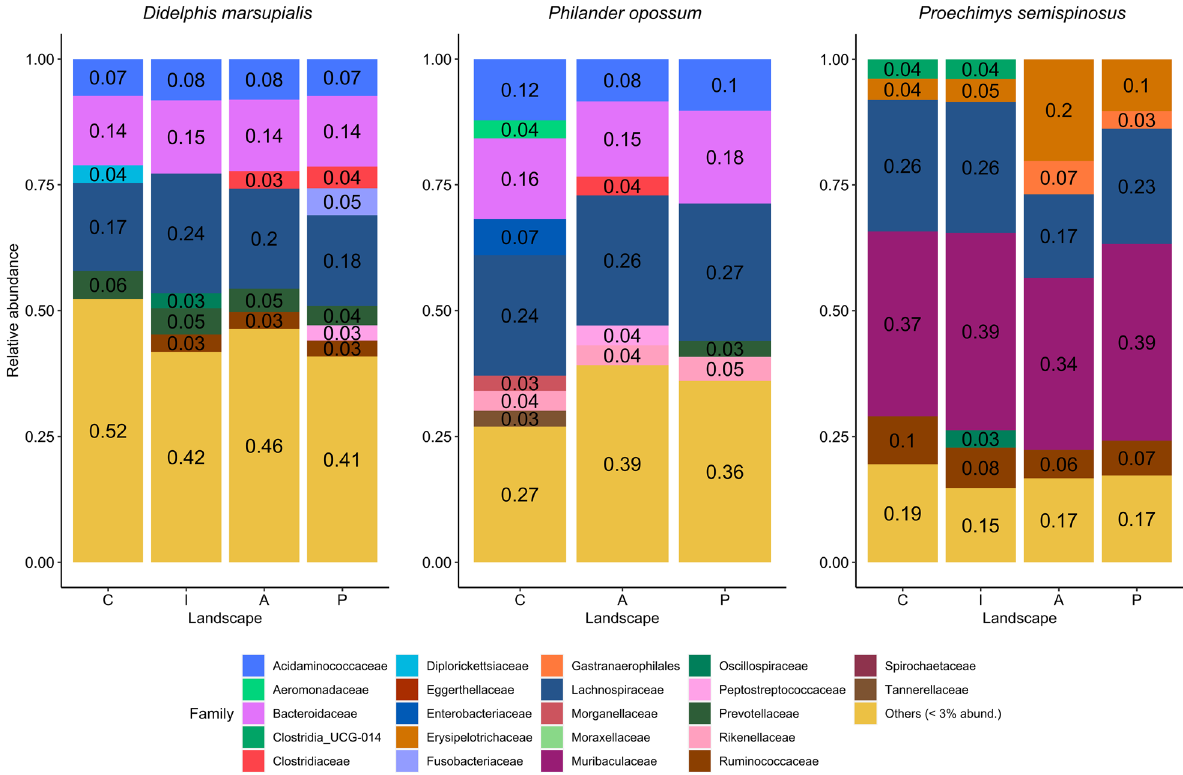
Fig. 1 Gut bacterial composition (at the family level) of the two marsupials ( D. marsupialis , P. opossum ) and the spiny rat ( P. semispinosus ). Details on the landscapes C, I, A and P are provided in the methods and their locations are shown in Additional file 1: Fig. S1. Note that P. opossum was not captured in landscape